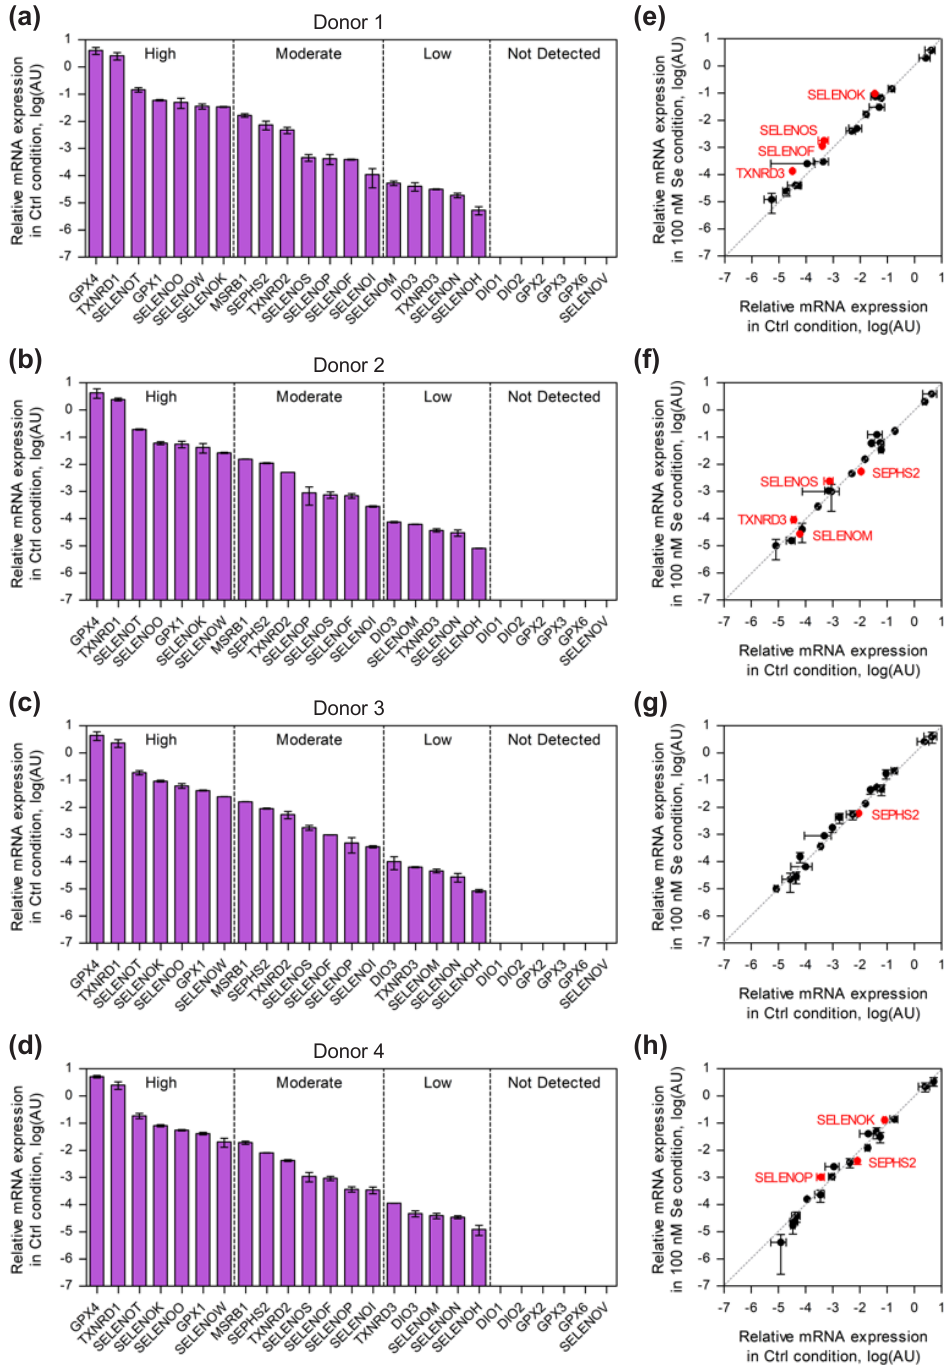
Figure 2. Analysis of selenoprotein mRNA levels in CD4-T cells isolated from donors in control conditions (Ctrl) and selenium-supplemented (100 nM) conditions after three days. The levels are represented in logarithmic scales. The transcripts from four different donors were measured and normalized similarly to what has been done for Jurkat and SupT1 extracts. The mRNAs expressed in control conditions were represented as histograms ( a – d ) and arbitrarily separated in high, medium and low abundance by dashed lines. Additionally, the values obtained in selenium-supplemented conditions (100 nM) were plotted as a function of values obtained with unsupplemented ones for every donor ( ± standard deviation) ( e – h ). The values are given in Table S2. The experiments were done in biological duplicates and in technical triplicates. The selenoprotein genes with significant changes are labeled in red and the statistical analyses are given in Table